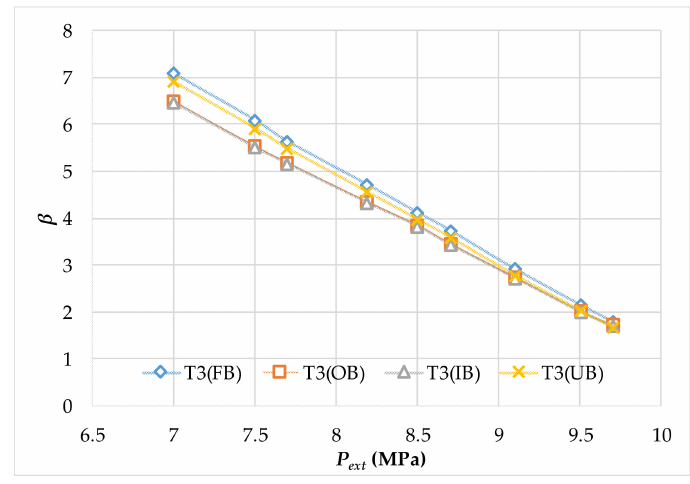
Figure 12. β as a function of external